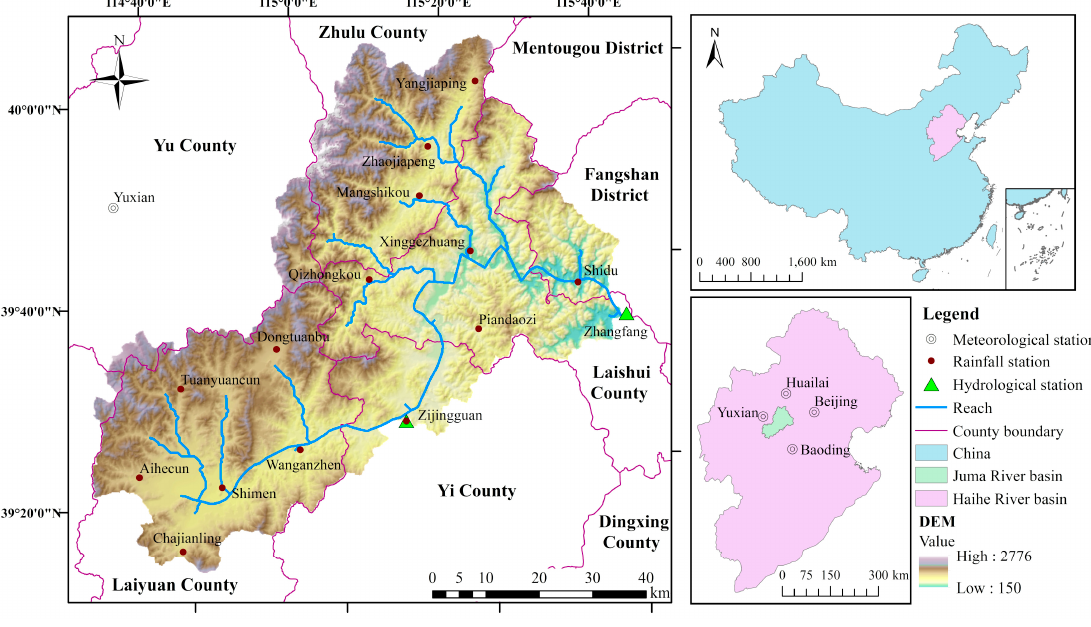
Figure 1. The Juma River basin.